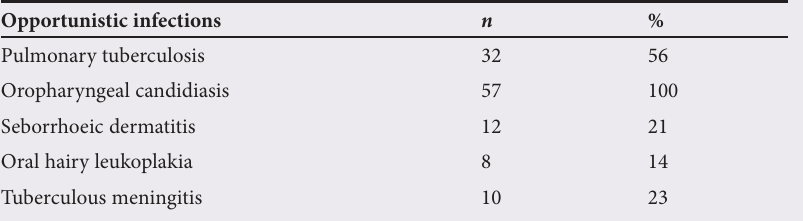
Table 2. Concurrent opportunistic infections and comorbidities in patients with cryptococcal meningitis ( N =57) Opportunistic